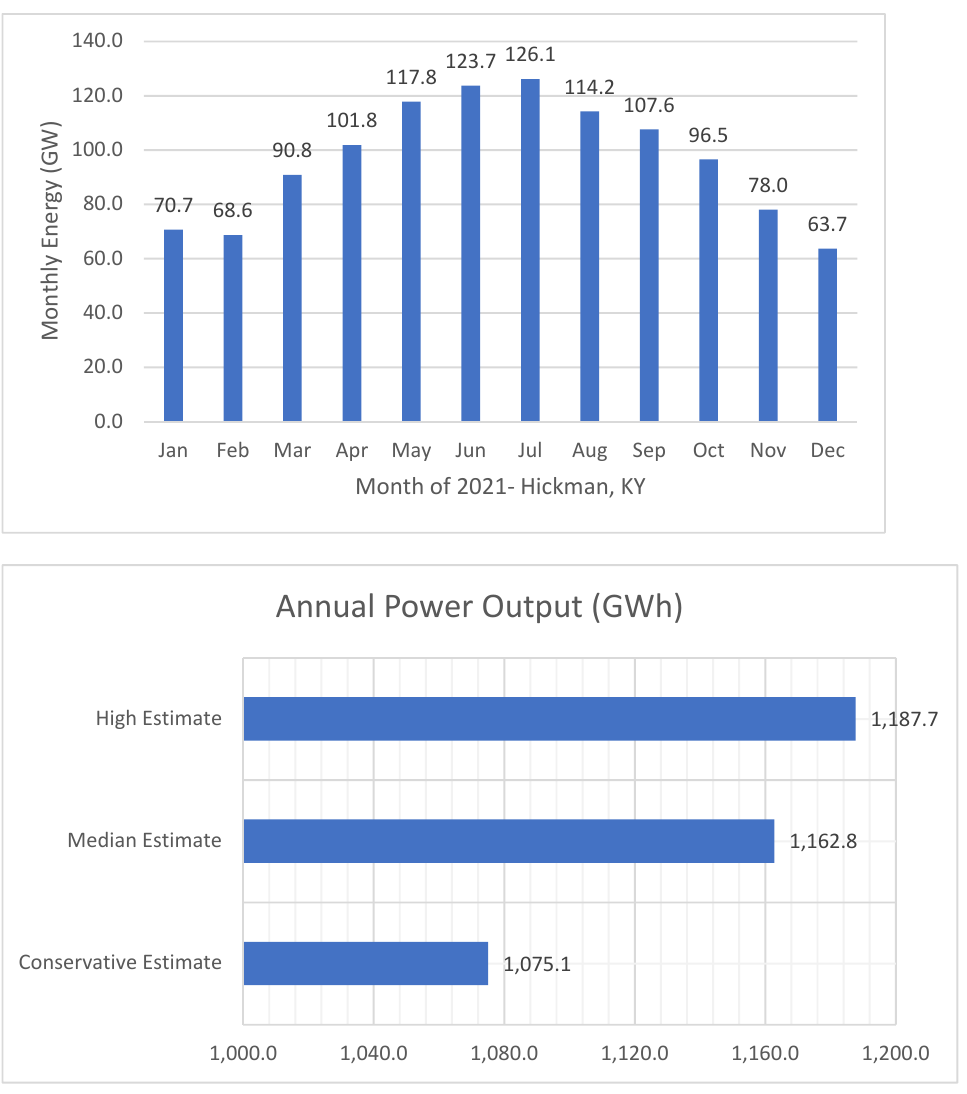
Figure 15 . Graphs of estimated GWh produced over a one-year period for potential Hickman solar farm monthly (17.1: Upper ) and annually (17.2: Lower ) [27,29]. Table 4. Regarding estimates of yearly power generation by potential Hickman solar farm. Percent- ages are based off average annual electricity consumption in Kentucky [27,29].